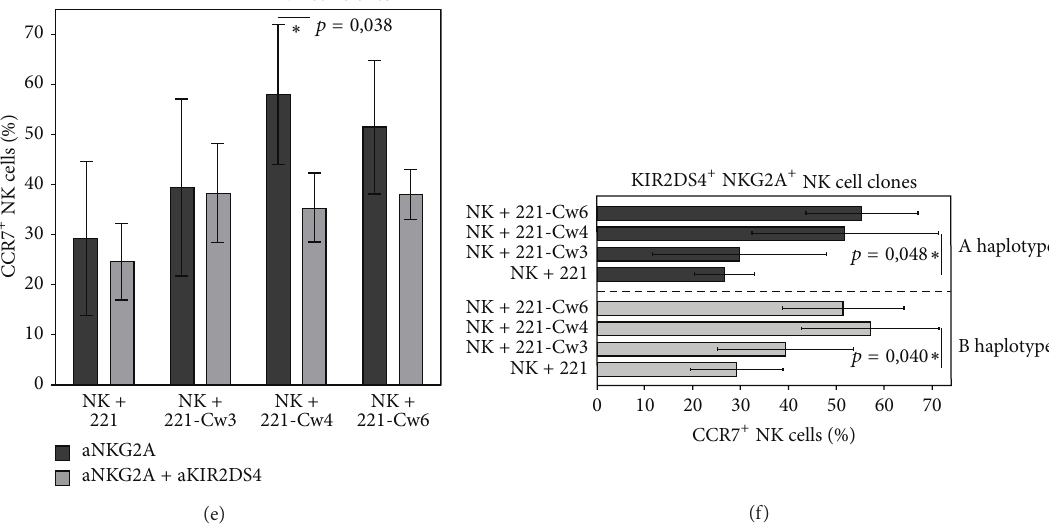
Figure 1: De novo expression of CCR7 in NK cell clones upon interaction with transfected 221 cell lines: comparison between KIR2DS4 + and KIR2DS4 − NK cell populations. (a) Expression profile of HLA-C and HLA-E molecules (left panels) and of CCR7 receptor (right panel) on 221 cells or 221 cells transfected with HLA-Cw3 or HLA-Cw4 or HLA-Cw6 is shown. (b) KIR2DS4 − NKG2A + or KIR2DS4 + NKG2A + NK cell clones were incubated with untransfected 221 cells or 221 cells transfected with HLA-Cw3 or HLA-Cw4 or HLA-Cw6 alleles. NK cell clones (6 for each type) were derived from one B haplotype donor. Coincubation was performed in the absence or presence of anti-NKG2A mAbs, as indicated. The histogram represents the percentage of CCR7 + NK cells after incubation with untransfected or HLA-transfected 221 cells. The average of 6 independent experiments and standard deviation (mean ± SD) are indicated. ∗∗ 𝑝 < 0.01 ; ∗ 𝑝 < 0.05 . (c) KIR2DS4 − NKG2A + or KIR2DS4 + NKG2A + NK cell clones (from one B haplotype donor) were incubated with 221-Cw4 cells. 3 KIR2DS4 − NKG2A + and 3 KIR2DS4 + NKG2A + NK cell clones characterized by low NKG2A-mediated inhibition (on the left) and 3 KIR2DS4 − NKG2A + and 3 KIR2DS4 + NKG2A + characterized by high NKG2A-mediated inhibition (on the right) are represented. The average of 6 independent experiments and standard deviation (mean ± SD) are indicated. ∗∗ 𝑝 < 0.01 ; ∗ 𝑝 < 0.05 . (d) A representative KIR2DS4 + NKG2A + NK cell clone (derived from one B haplotype donor) was incubated at 37 ∘ C with CCR7 + untransfected 221 cells or 221 cells transfected with HLA-Cw4. After 30 minutes, NK cells were harvested and stained with anti-CD56 and anti-CCR7 mAbs for cytofluorimetric analysis. The percentages of CCR7 + cells are indicated in the upper-right corners. (e) KIR2DS4 + NKG2A + NK cell clones derived from the one B haplotype donor were incubated with untransfected 221 cells or 221 cells transfected with HLA-Cw3 or HLA-Cw4 or HLA-Cw6 alleles. Coincubation was performed in the absence or in the presence of mAbs to the indicated molecules. The histogram represents the percentage of CCR7 + NK cells after incubation with untransfected or HLA-transfected 221 cells. The average of 6 independent experiments and standard deviation (mean ± SD) are indicated. ∗ 𝑃 < 0.05 . (f) KIR2DS4 + NKG2A + NK cell clones derived from one A haplotype donor (upper panel) and one B haplotype donor (lower panel) (3 for each haplotype) were incubated with untransfected 221 cells or 221 cells transfected with HLA-Cw3 or HLA-Cw4 or HLA-Cw6 alleles. The average of 3 independent experiments and standard deviation (mean ± SD) are indicated. ∗ 𝑝 < 0.05